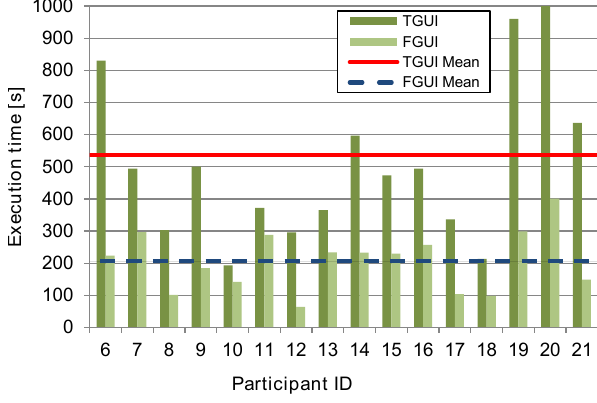
Figure 8: Individual performance in task execution with TGUI and